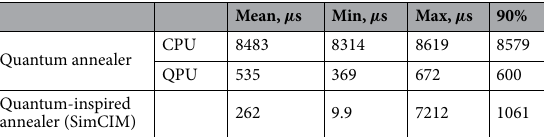
Table 1. Genome assembly time for φ X 174 bacteriophage for 1000 instances. For the data based on